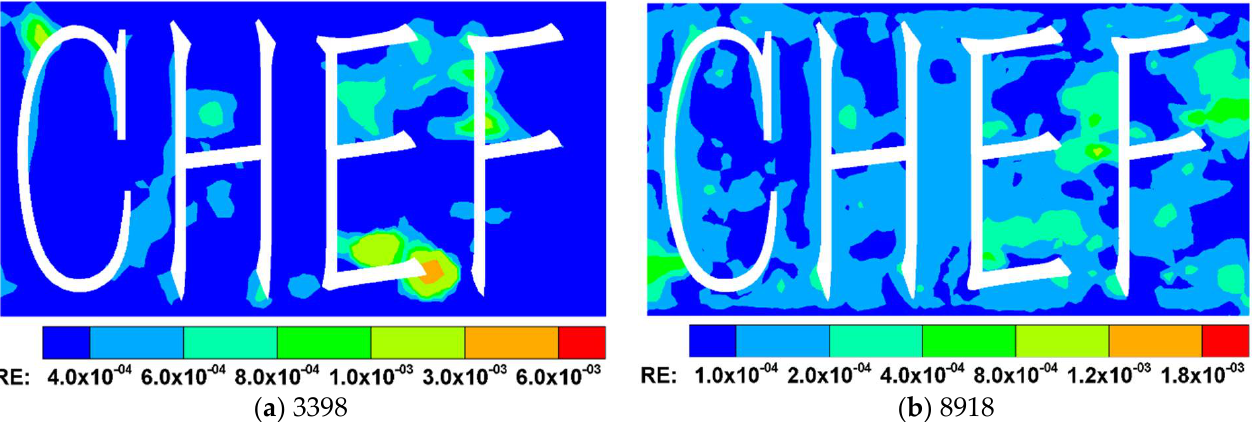
Figure 8. The contours of relative errors of hydraulic head H with two distributions of collocation nodes.